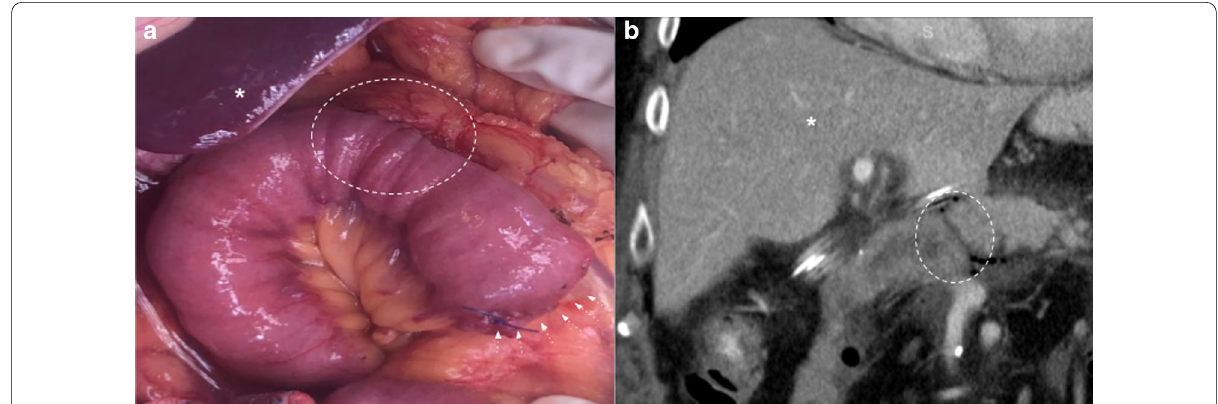
Fig. 3 Pancreaticojejunostomy. Duct-to-mucosa. CT-surgical correlation: ( a ) Surgical photograph. ( b ) Contrasted Coronal CT scan. References: Duct-to-mucosa pancreaticojejunostomy (discontinuous circle); blind segment of afferent limb (small arrows); liver (asterisk)